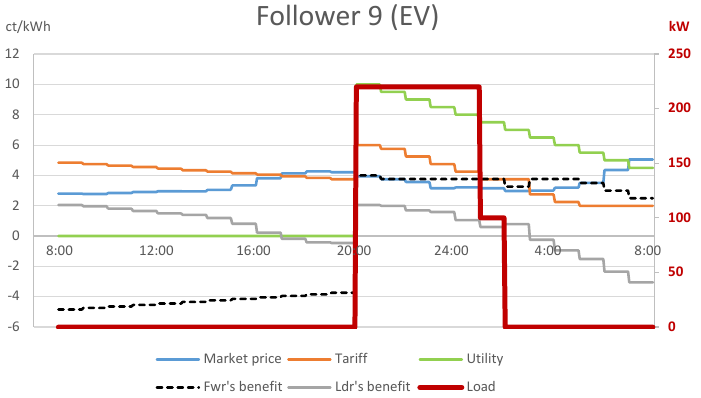
Figure 3. Optimistic bilevel solution: consumption of follower 9 with EV